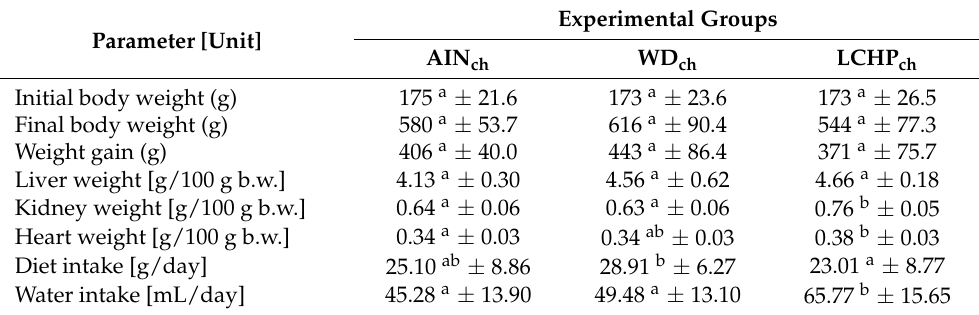
Figure 2. Intake of diet (g) of rats fed AIN ch , WD ch (Western diet) or LCHP ch (low-carbohydrate– high-protein) diets enriched with 1% cholesterol during the experiment (0–8 weeks). Table 2. Body weights, weight gain, diet and water intake as well as the weights of liver, kidney and heart of Wistar rats after 8 weeks of feeding: AIN ch ; WD ch (Western diet) or LCHP ch (low- carbohydrate–high-protein) diets, enriched with 1%